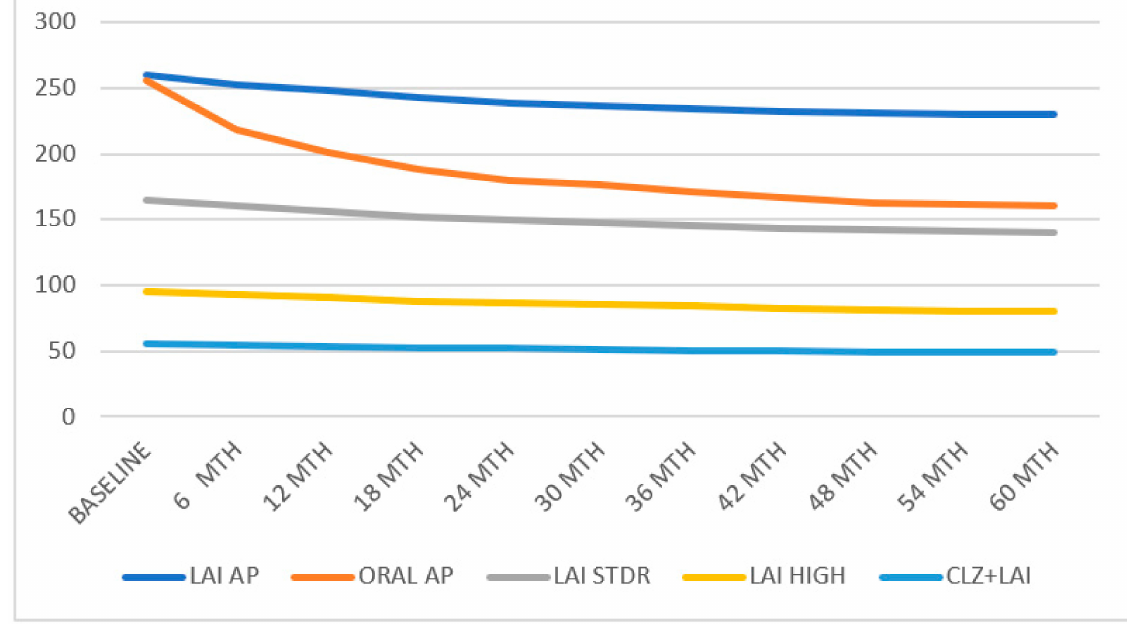
Figure 2. All groups’ treatment